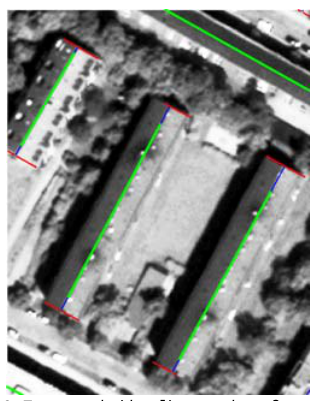
Figure 6. Extracted ridge lines and roof parameters